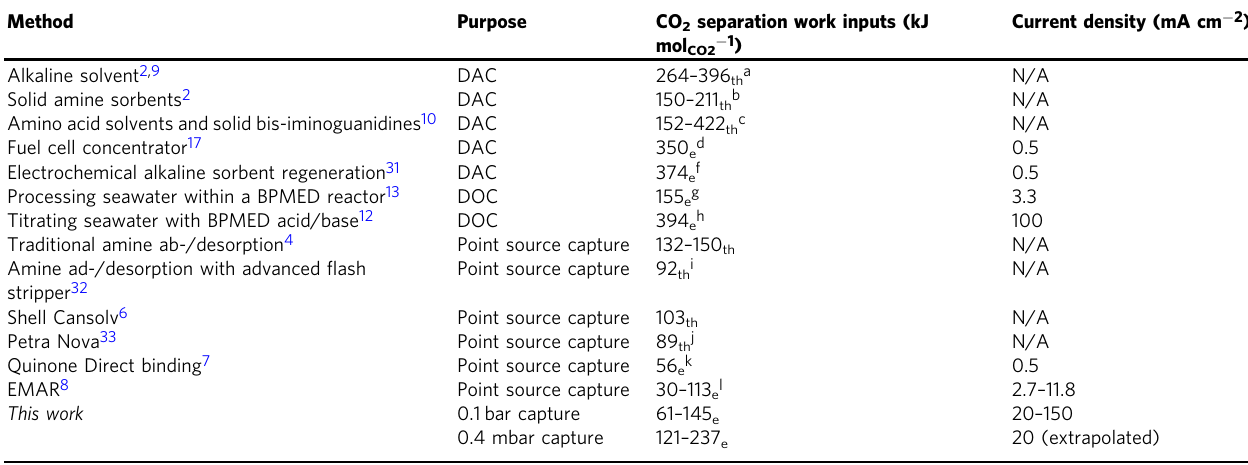
Table 2 Comparison of this work and emerging technologies for DAC, DOC, and point source capture. CO 2 separation work with “ th ” subscript denotes thermal energy inputs, whereas “ e ” subscript denotes electrical work